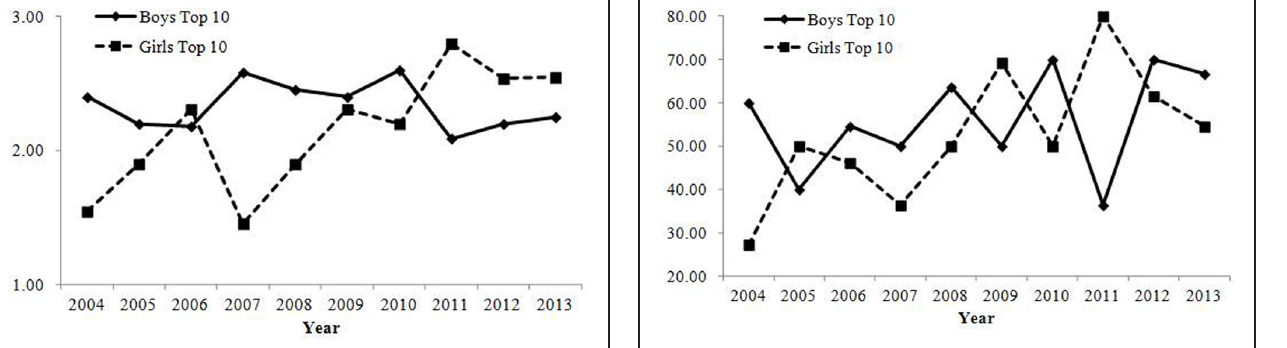
FIGURE 8 | Percentage of names having more than two pronunciations among the top 10 most common combinations of Chinese characters in Study 2. The number of names with several pronunciations increased both for boys and girls over the